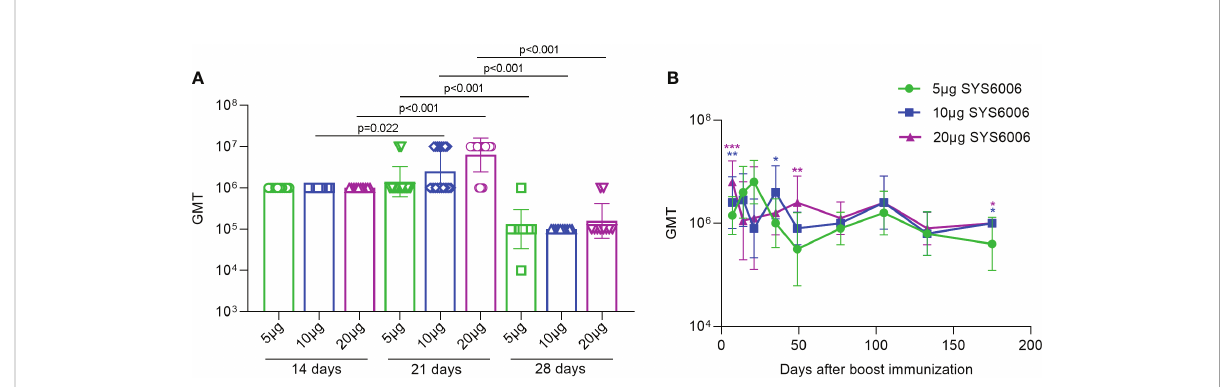
FIGURE 2 The GMTs of S1-speci fi c IgG antibodies against Delta variant in the sera of the vaccinated mice under various immunization strategies. 6-8- week-old female BALB/c mice were immunized intramuscularly with the indicated doses of SYS6006 and boosted with an equal dose on day 14, 21 or 28 post initial immunization. Sera were collected from mice 7 days after boost immunization and used to detect the geometric mean titers (GMTs) of S1-speci fi c IgG antibodies against Delta variant (A) . Sera were also collected from mice at the indicated time points after 2-dose immunization with 21-day interval and used to detect the GMTs of S1-speci fi c IgG antibodies against Delta variant (B) . Data are presented as geometric mean ± geometric SD. *P<0.05, **P<0.01, ***P<0.001 vs. mice immunized with 5 m g of